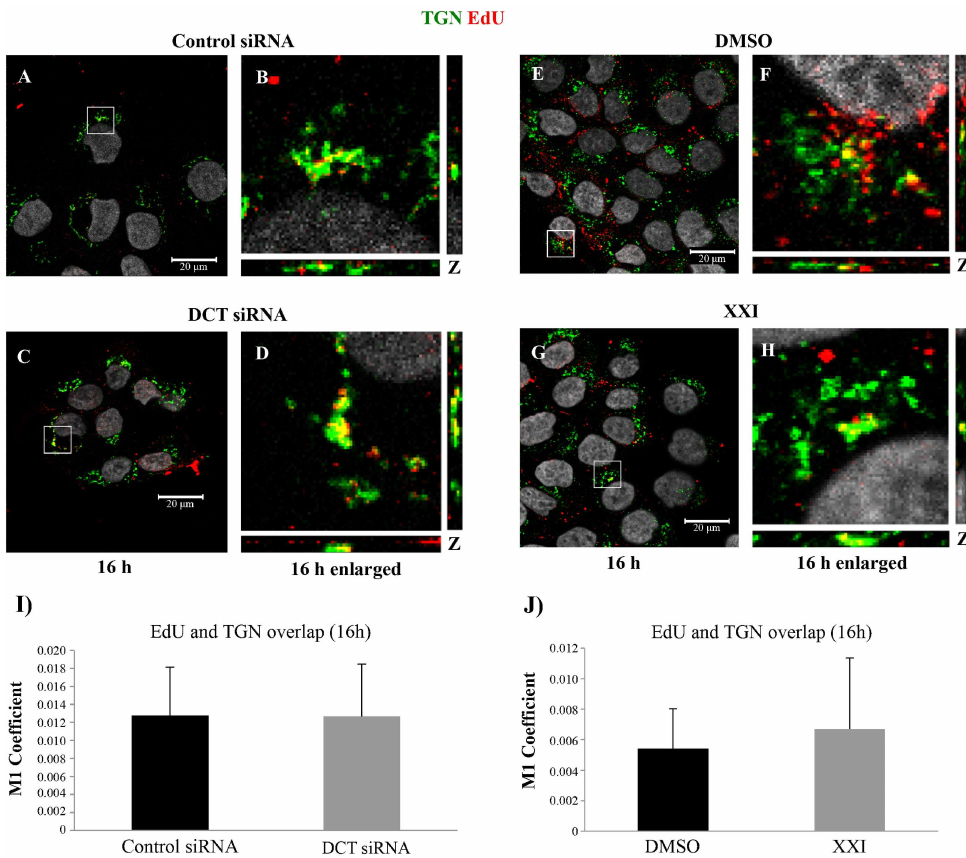
Fig 3. Colocalization of TGN with EdU-labeled pseudogenome is not affected by DCT siRNA or XXI treatment of HaCaTs at 16hpi. (A-H) control siRNA, DCT siRNA, DMSO or XXI, treated HaCaTs were infected with HPV16 PsV harboring EdU-labeledpseudogenome. TGN was stained with TGN-46 (green), EdU-labeled pseudogenome was visualized by Click-iT reaction (red) and the nuclei were stained with DAPI (grey). Colocalization of EdU and TGN appears yellow (I and J) The JACoP plugin for ImageJ was used to measure the M1 coefficient (fraction of red signal overlappingwith green signal) with three confocal scans for each